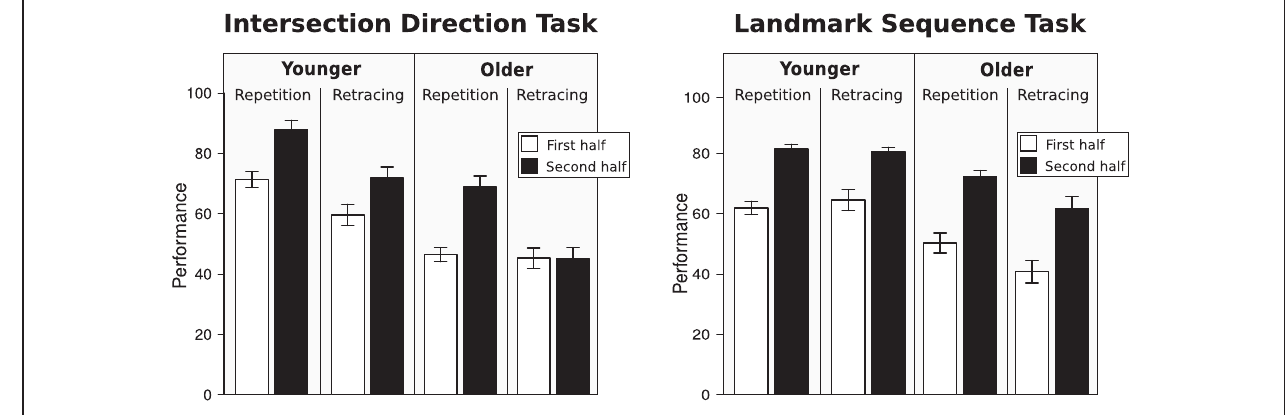
FIGURE 3 | Left: performance for the Intersection Direction Task ; right: performancre in the Landmark Sequence Task